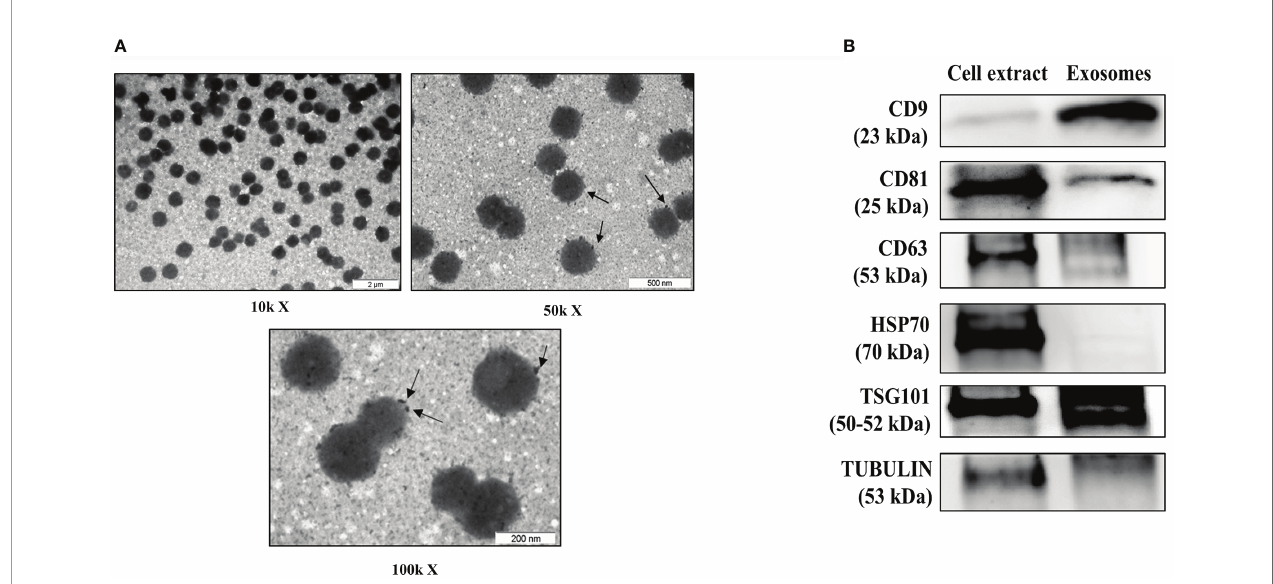
FIGURE 1 | Characterization of serum-derived exosomes. (A) Analysis of early RA serum exosomes by electron microscopy. Arrows indicates osmium tetroxide deposition on exosome lipid surface. (B) Representative western blot of protein extracts prepared from exosomes isolated from serum of patients with early RA and total cell extract from the human monocytic cell line THP-1 as a control, tested with the following antibodies: CD9, CD81, CD63, HSP70, TSG101 and tubulin. m m, micrometers, kX magni fi cation levels; kDa,